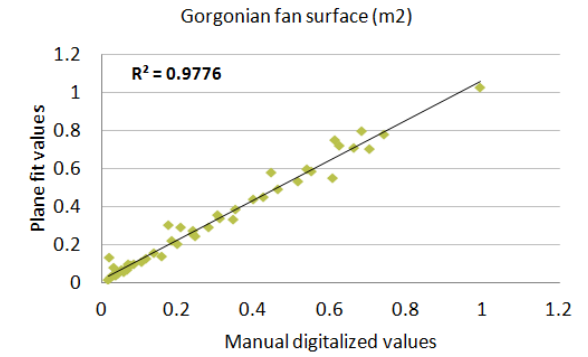
Figure 7: Plane fitting RMS of 188 gorgonian 3D point clouds The difference between manual procedure based in the sum of planar triangles and semi-automatic method to adjust a unique fitting plane in 47 colonies was -0.134 m 2 and 0.059 m 2 . Linear regression shows an adjustment of 0.97 for the R 2 value (Fig.8).